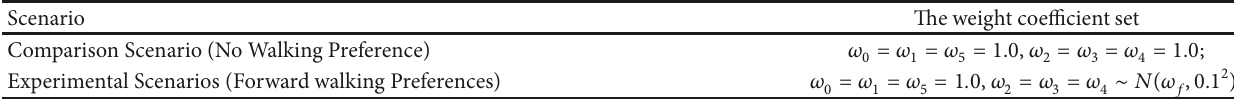
Table 4: Weight coefficient set in each scenario.